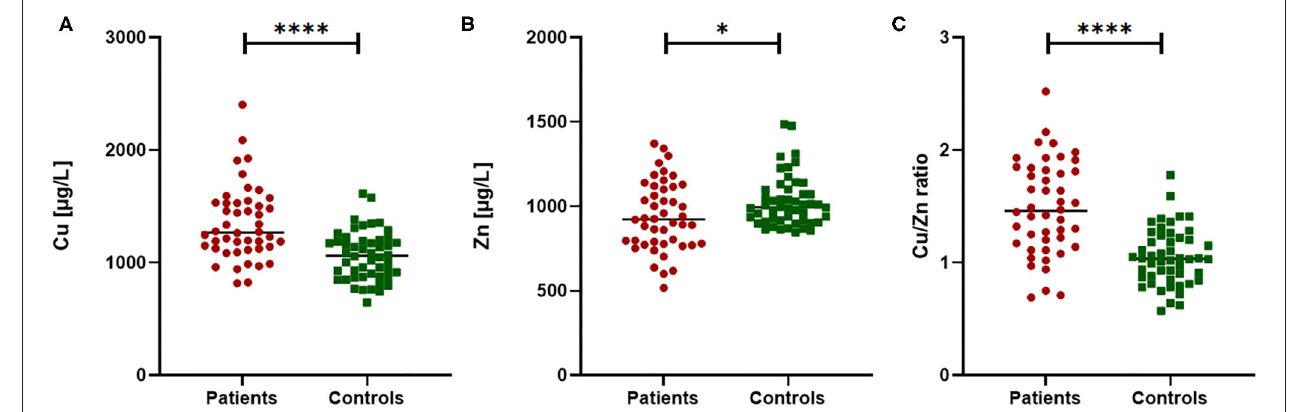
FIGURE 1 | Comparison of Cu, Zn and Cu/Zn ratio in PTC patients vs. healthy controls. Significant differences were observed in plasma Cu concentration (A) , Zn concentration (B) and in the Cu/Zn ratio (C) . Mann Whitney test for non-normal distribution or T -test for variables normally distributed; * p < 0.05 and **** p < 0.0001.